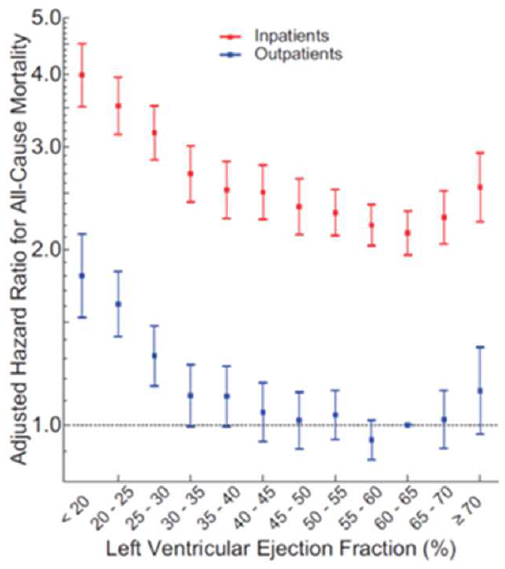
Figure 1. Left ventricular ejection fraction (LVEF) adjusted hazard ratios (HR) in patients with heart failure. Reprinted with permission from Wehner GJ, Jing L, Haggerty CM et al. Routinely reported ejection fraction and mortality in clinical practice: where does the nadir of risk lie? Eur. Heart J.